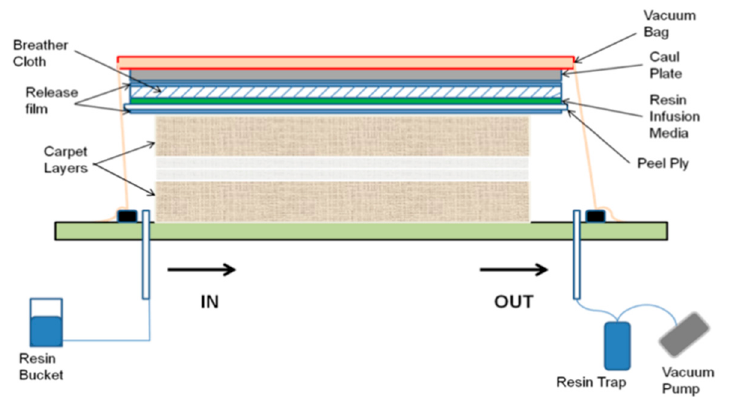
Figure 2. Schematic diagram of the mold for the VARTM process.